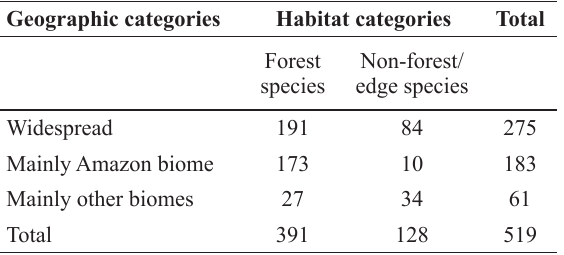
Number of bird species in the Carajás National Forest distributed by geographical and habitat association